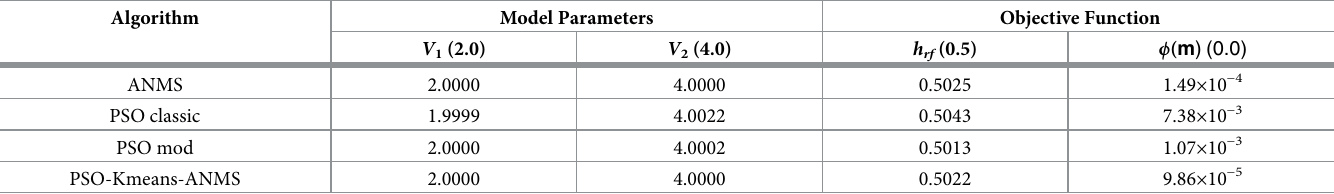
Table 14. Case 3 (100 × 10). Results of model parameters and the respective objective function (misfit) for the best solutions obtained in each optimization algorithm. Algorithm